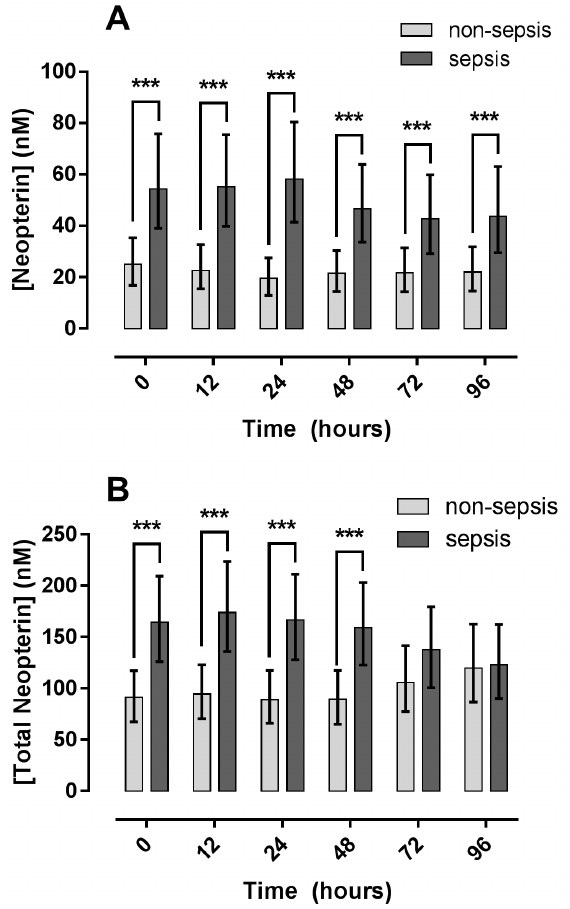
Figure 2: Plasma neopterin (A) and total neopterin (B) for non- sepsis and sepsis patients for 96 hours following admission to ICU. Sepsis plasma neopterin (pNP) is highly significantly elevated over non-sepsis for all time points. Sepsis total neopterin (pTNP) is significantly elevated for 48 hours, but is equal to non-sepsis by 96 hours. Data is presented as means and their respective 95%